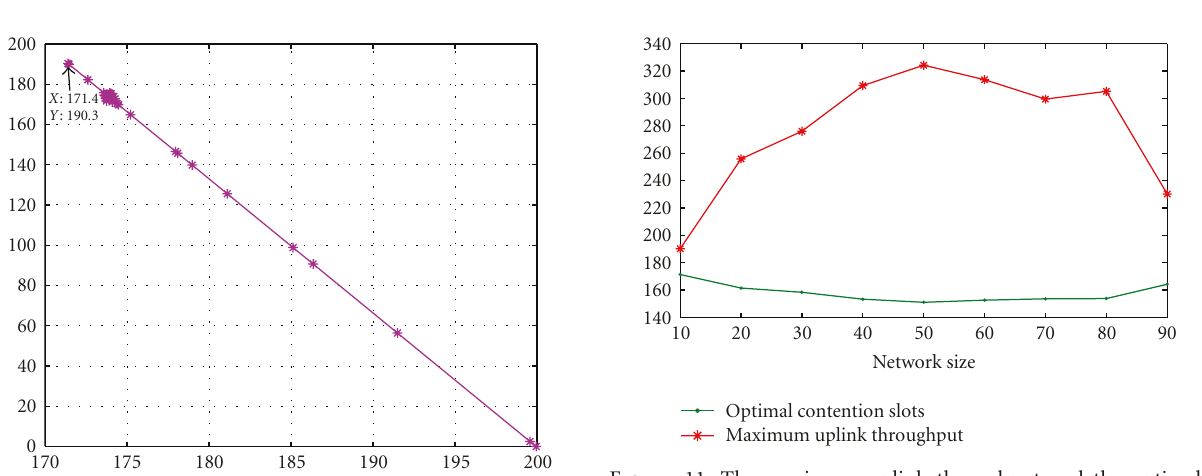
Figure 11: The maximum uplink throughput and the optimal- contention-request period with di ff erent network